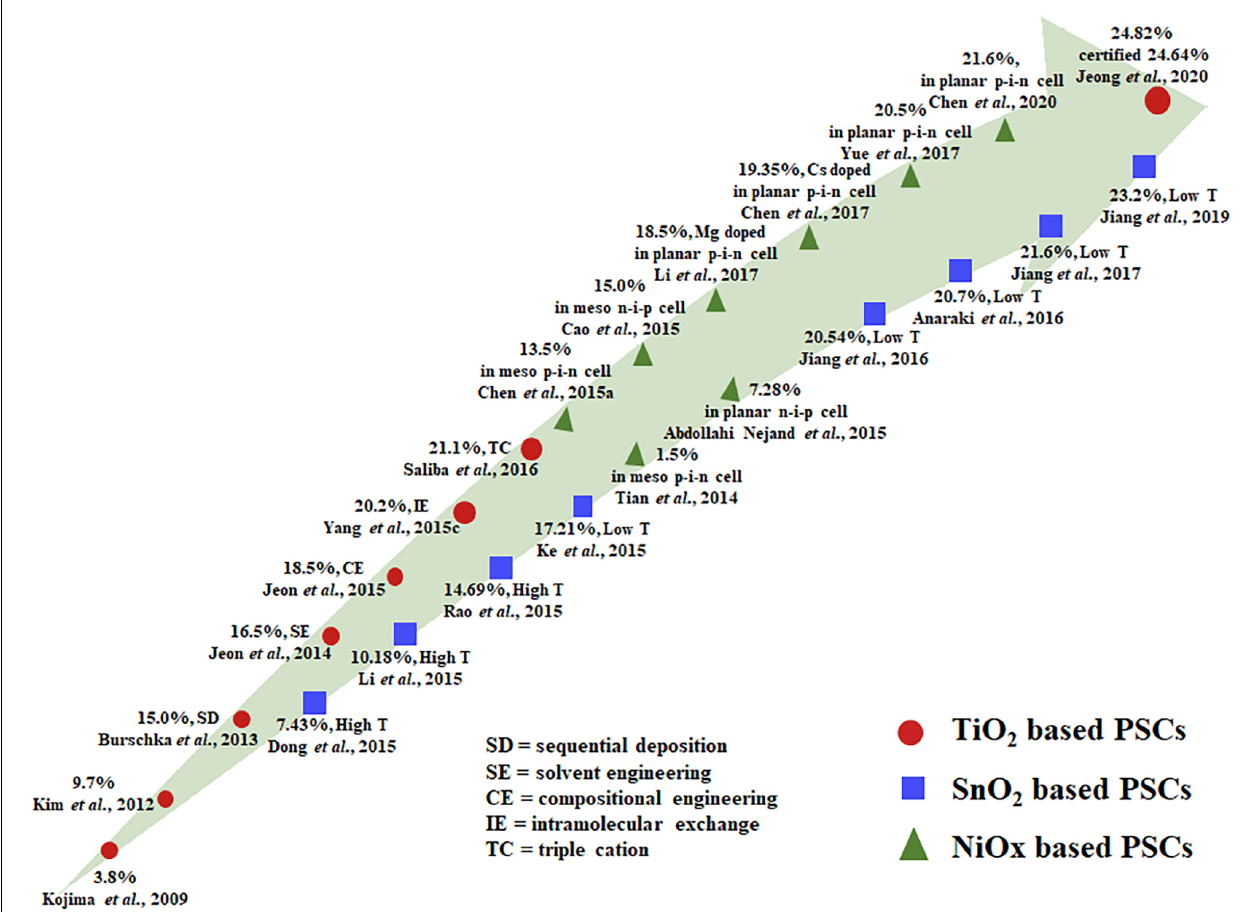
FIGURE 1 | The evolution of perovskite solar cell using various metal oxide charge transport